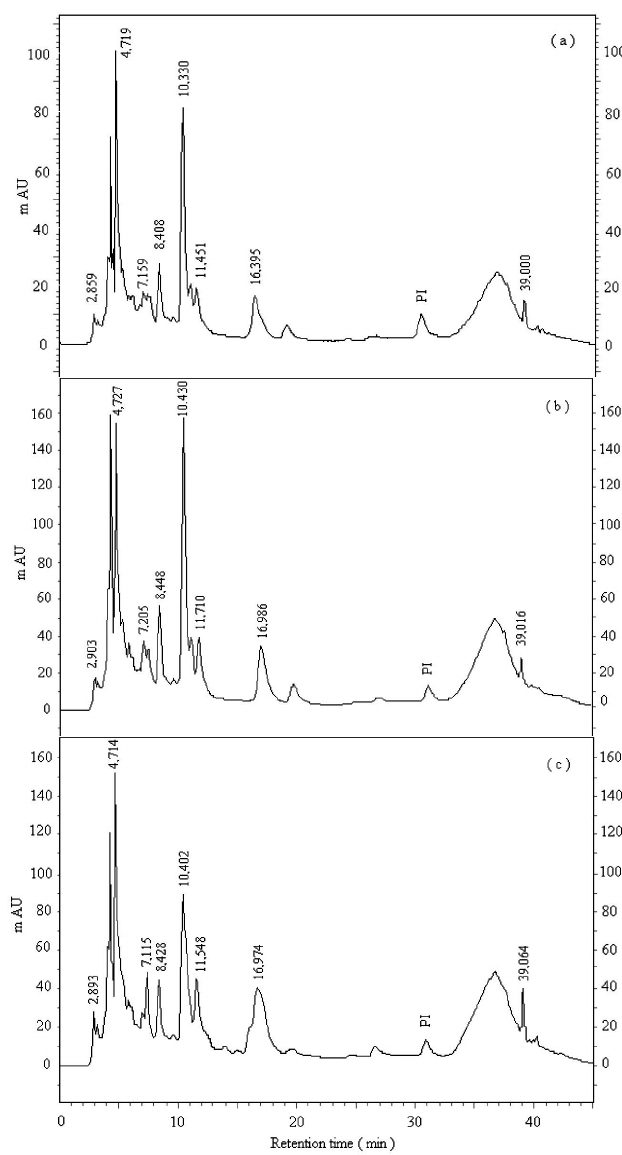
FIGURE 1 - HPLC fingerprint analysis of the Bauhinia forficata extracts (a: concentrated extract, b: spouted bed dried extract, and c: spray dried